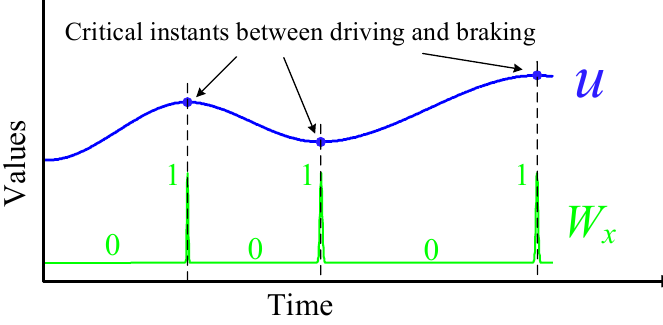
Figure 3. The value of W x with varying longitudinal velocity.